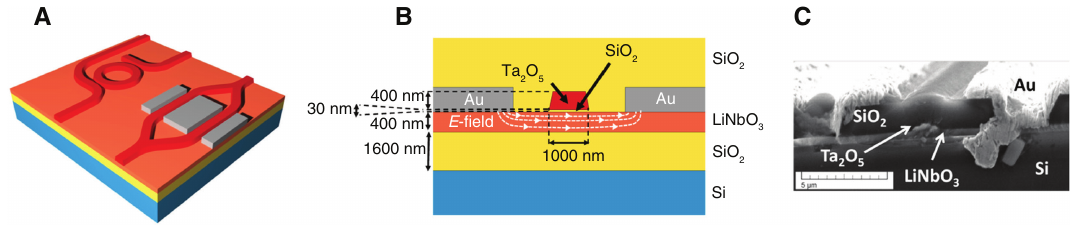
Figure 6: Rib loaded waveguides with Au electrodes. (A) Schematic view, (B) cross section, and (C) scanning electron microscope image. Reprinted with permission from Rabiei et al. [27]. © The Optical